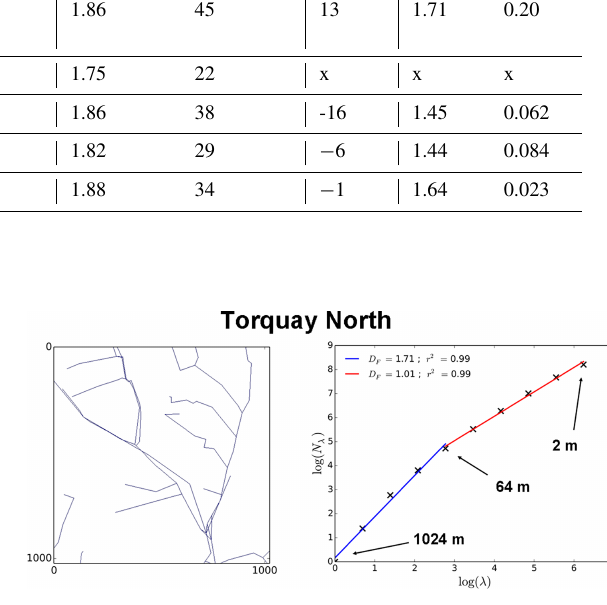
fractal dimension 1.81. Unique scale regimes are also found areas. The scaling regime is robust with visible straight